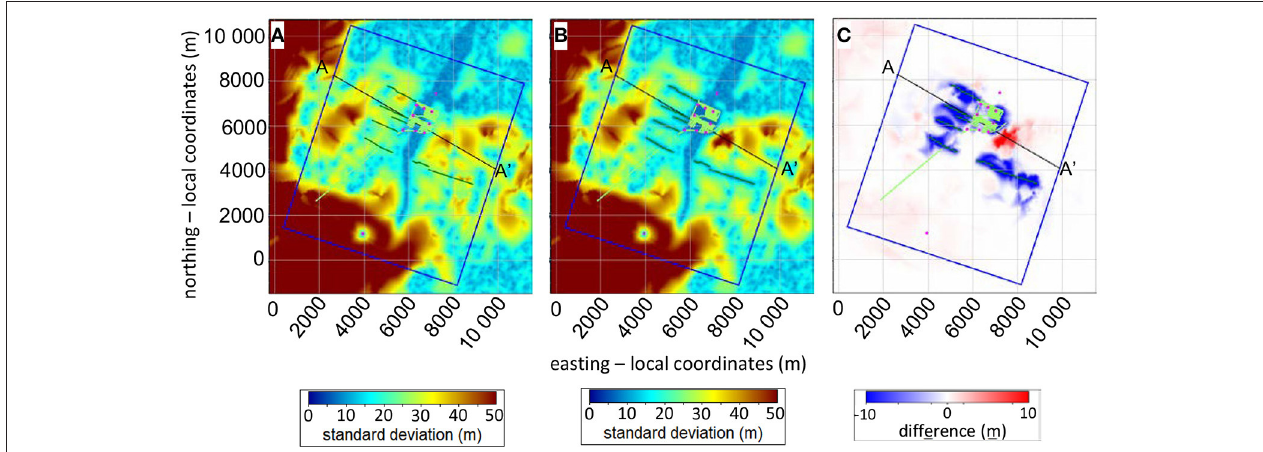
FIGURE 6 | Standard deviation of the Esker Sand and Gravel unit thickness map not using (A) and using (B) the seismic reflection data. Panel (C) is the difference between (B) and (A) . Black line is location of cross-section presented in Figure 8